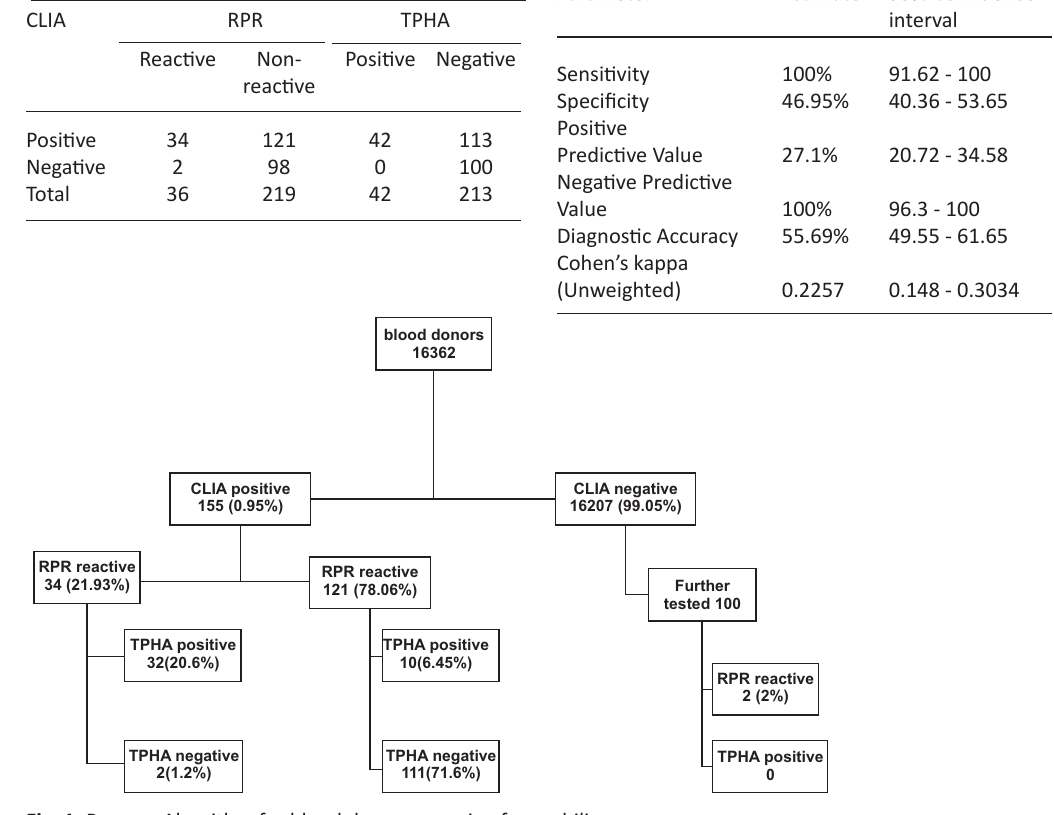
Fig. 1. Reverse Algorithm for blood donor screening for